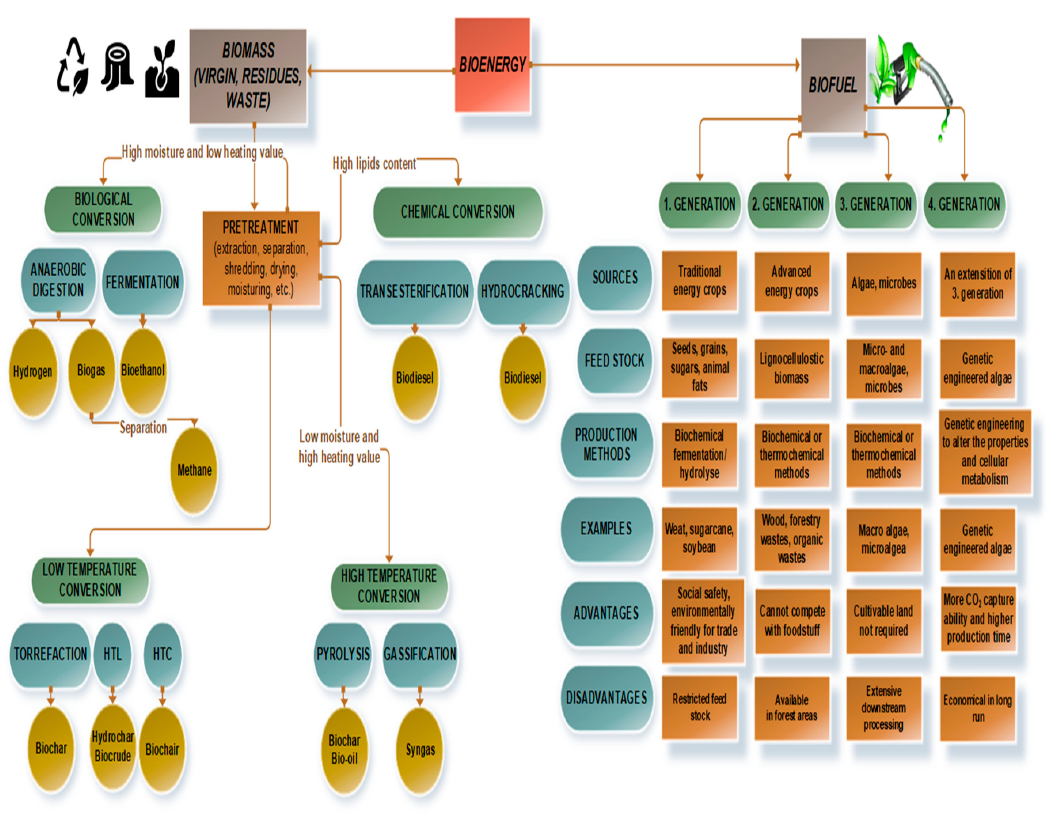
Figure 3. Overview of possible paths for conversion of biomass into biofuel and biofuel-based bioenergy. Adapted from [36].